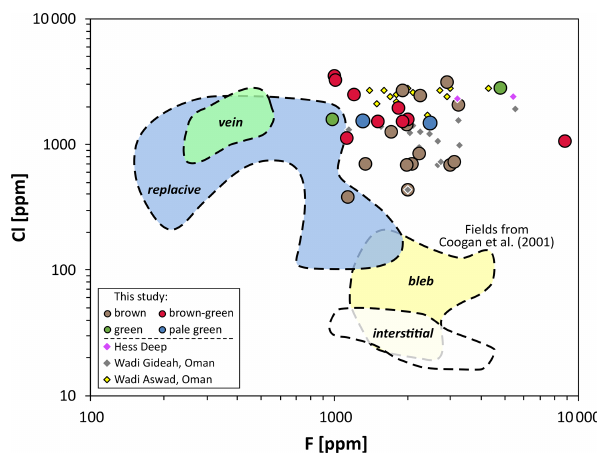
Figure 15. Concentration of F versus Cl in amphiboles from gab- bros of the OmanDP drill core GT3A in comparison to those from EPR Hess Deep (Gillis and Meyer, 2001), Oman ophiolite Wadi Gideah (Müller et al., 2017) and Oman ophiolite Wadi Aswad (France et al., 2021). Discrimination fields are from Coogan et al. (2001) for amphiboles related to magmatic (bleb, interstitial) or hydrothermal (vein, replacive) formations. These fields have been evaluated for gabbros from the Mid-Atlantic Ridge. Note that the amphiboles from Oman and those from EPR Hess Deep plot in an area with high Cl and F concentration, not covered by the discrimi- nation fields of Coogan et al.